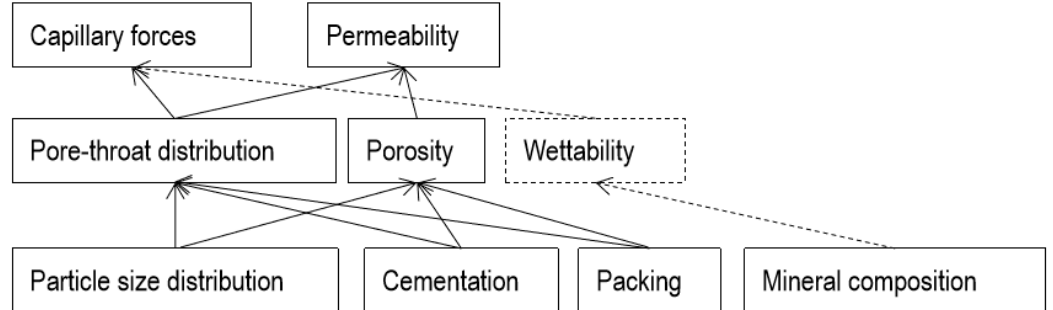
Figure 2. Physical parametric interaction pathways of the major petrophysical parameters in sedimentary rock affecting the chromatographic/transport/storage/chemical behavior of petroleum fluids and water (solid lines are rock properties).